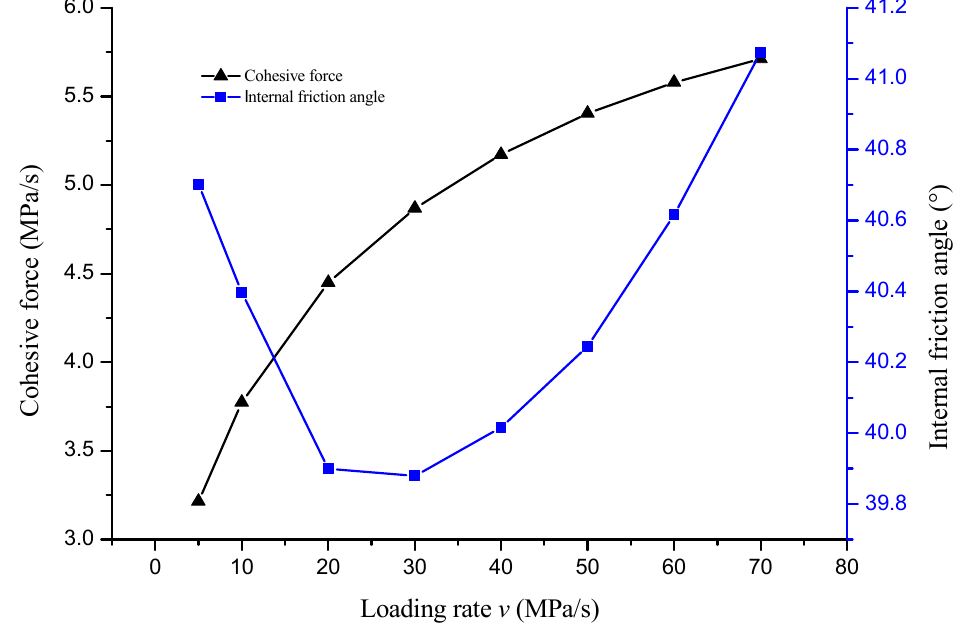
Figure 7. The variation of cohesive force and internal friction angle with loading rate.